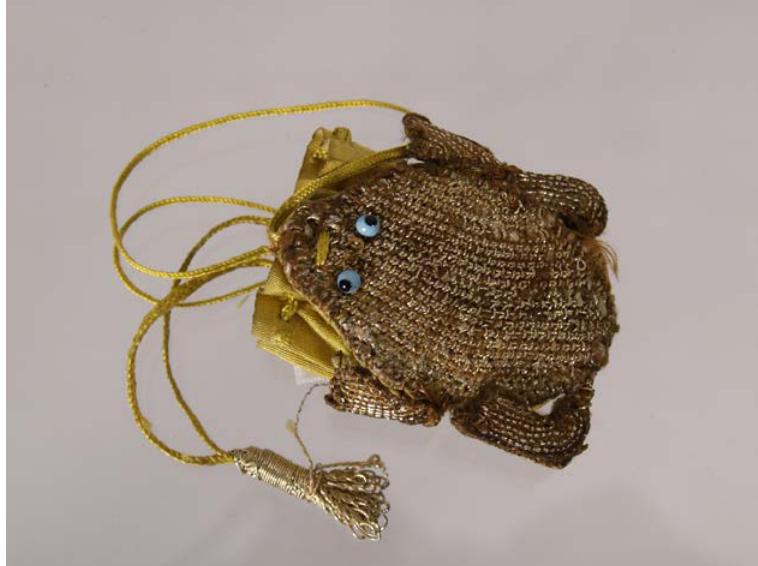
Figure 2 – Gold-coloured Crocheted Frog Bag. Metal thread (frog), yellow silk (bag), blue glass beads with black dots (eyes). Found in a stumpwork box, England, 1645. Anne Lambert Clothing and Textiles Collection (1992.15.1d). Photograph by Anne Bissonnette © Department of Human Ecology, University of